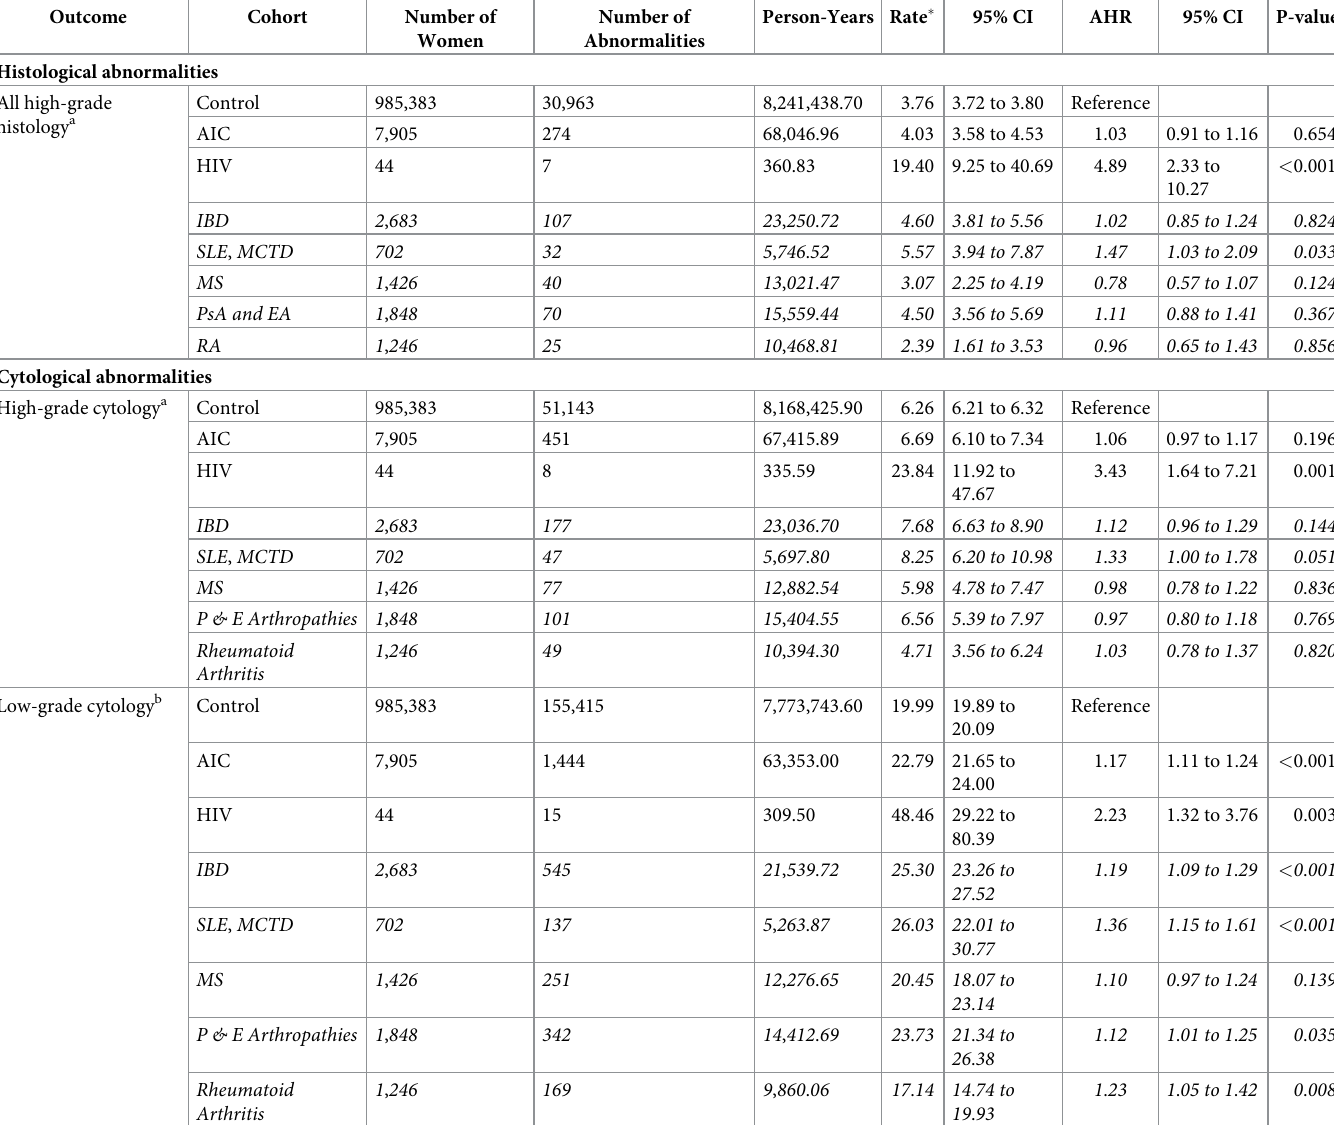
Table 2. Number, incidence rate and adjusted hazard ratios for cervical abnormalities of the control, auto-immune conditions and HIV cohorts. Outcome